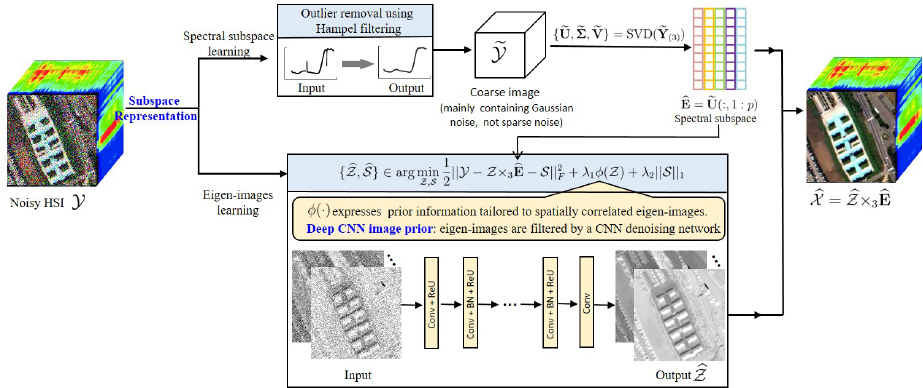
Figure 3. Flowchart of the proposed mixed noise removal method